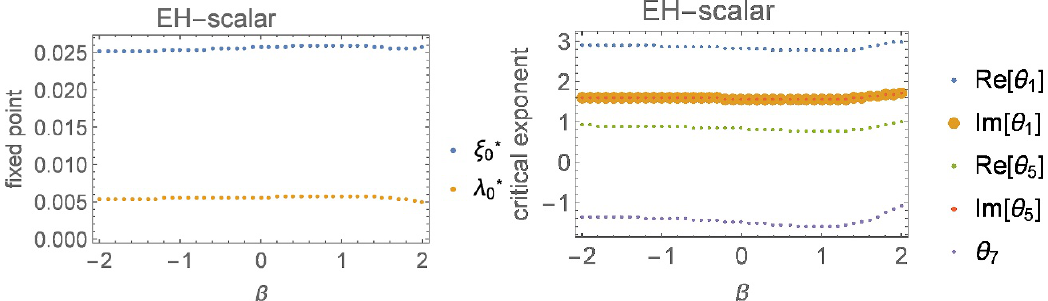
Figure 8 . The dependences of the stable (cid:12)xed point and the stable critical exponent on (cid:12) in the \EH-scalar" truncation.